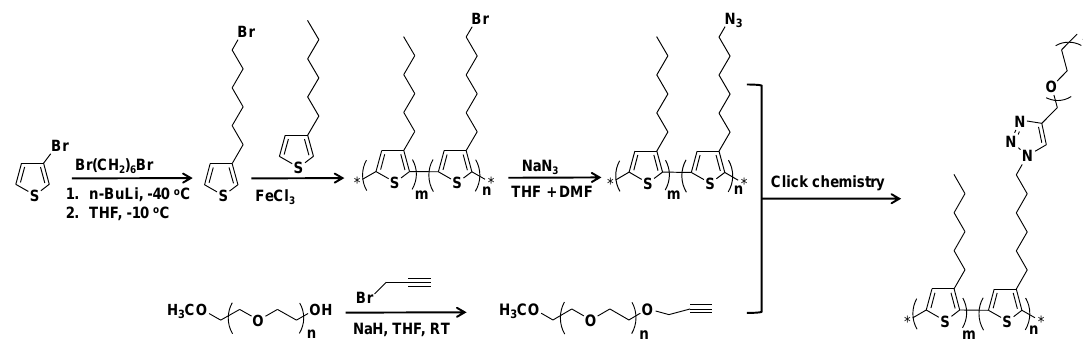
Scheme 4. Synthesis of P3HT– g –PEO random copolymers through oxidative polymerization and click reactions.